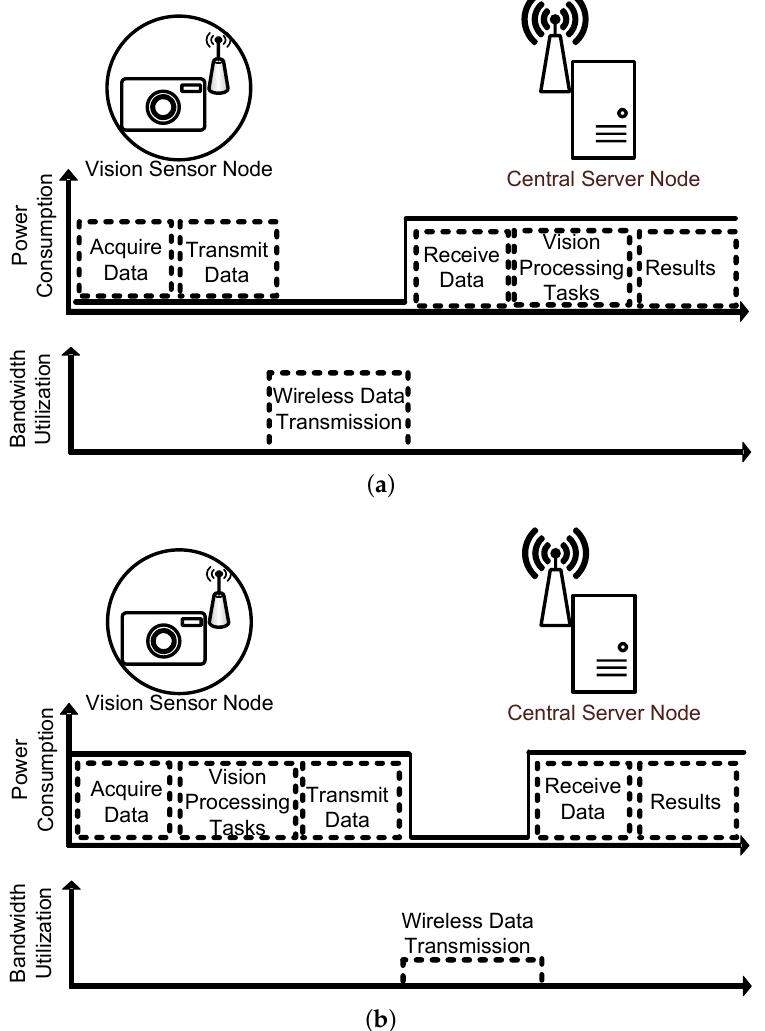
Figure 1. WVSN architectures. ( a ) No vision processing at sensor node; ( b ) all vision process at sensor